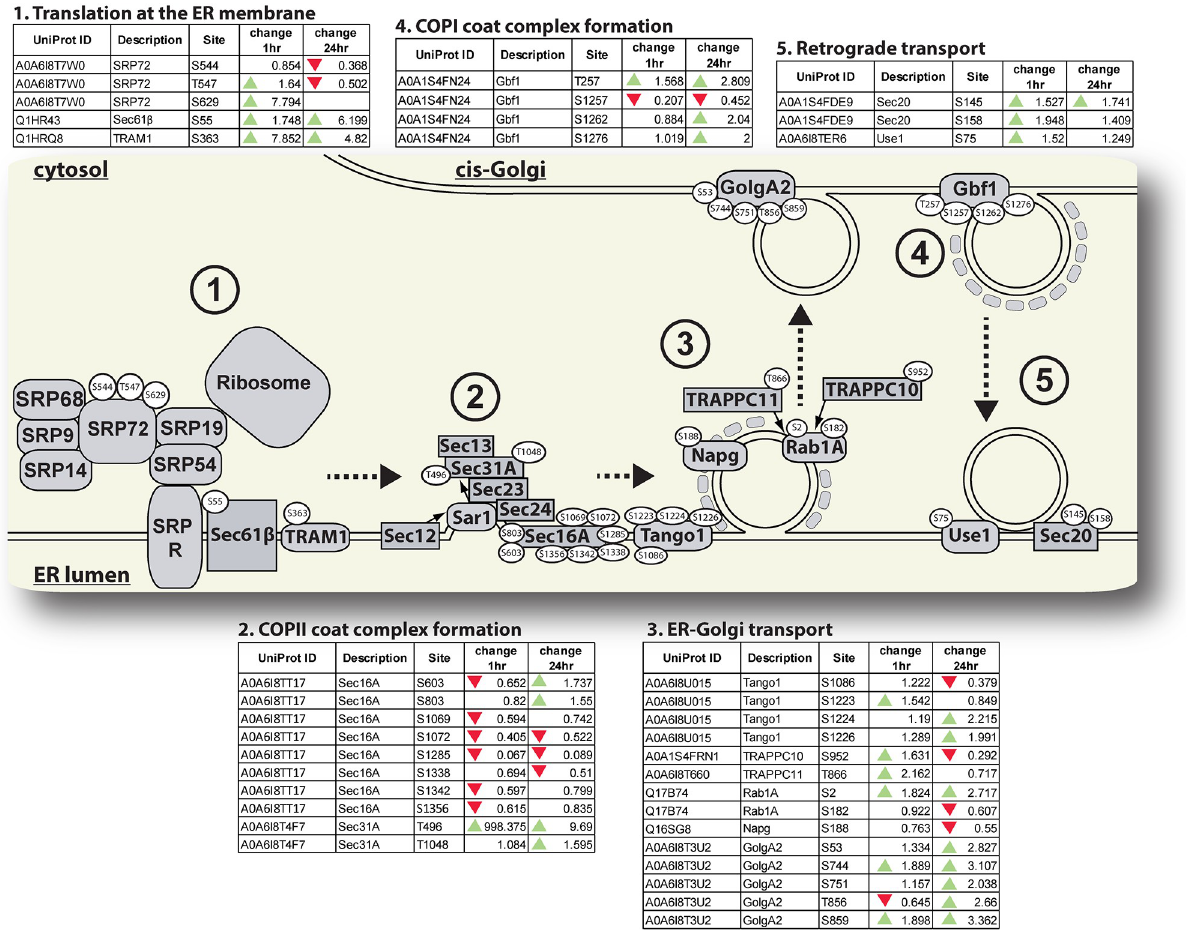
Fig 3. Changes in phosphorylation of proteins associated with co-translation and ER-Golgi vesicle traffic. Ae . aegypti proteins associated with co- translation and ER-Golgi transport conserved in other eukaryotic organisms are illustrated. Specific amino acid residues on proteins with phosphorylation changes of at least 1.5-fold between unfed and blood-fed mosquitoes are shown in white ovals. The numbers in the figure correspond to tables where proteins with related functions are grouped. Tables contain the Uniprot IDs for each protein as well as the fold-change in phosphorylation of each residue between unfed and either 1hr PBM or 24hr PBM mosquitoes. Green arrows represent an increase of at least 1.5-fold in phosphorylation at the specified residue between unfed and PBM mosquitoes, and red arrows represent a decrease of at least 1.5-fold in phosphorylation at the specified residue between unfed and PBM